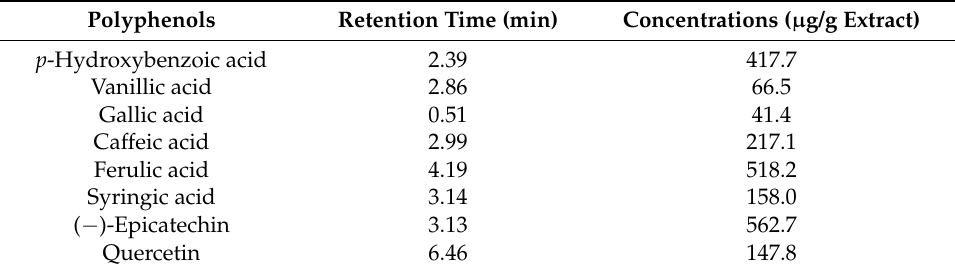
Table 3. Identified polyphenol contents of distiller’s grain extract tested by UPLC-MS.